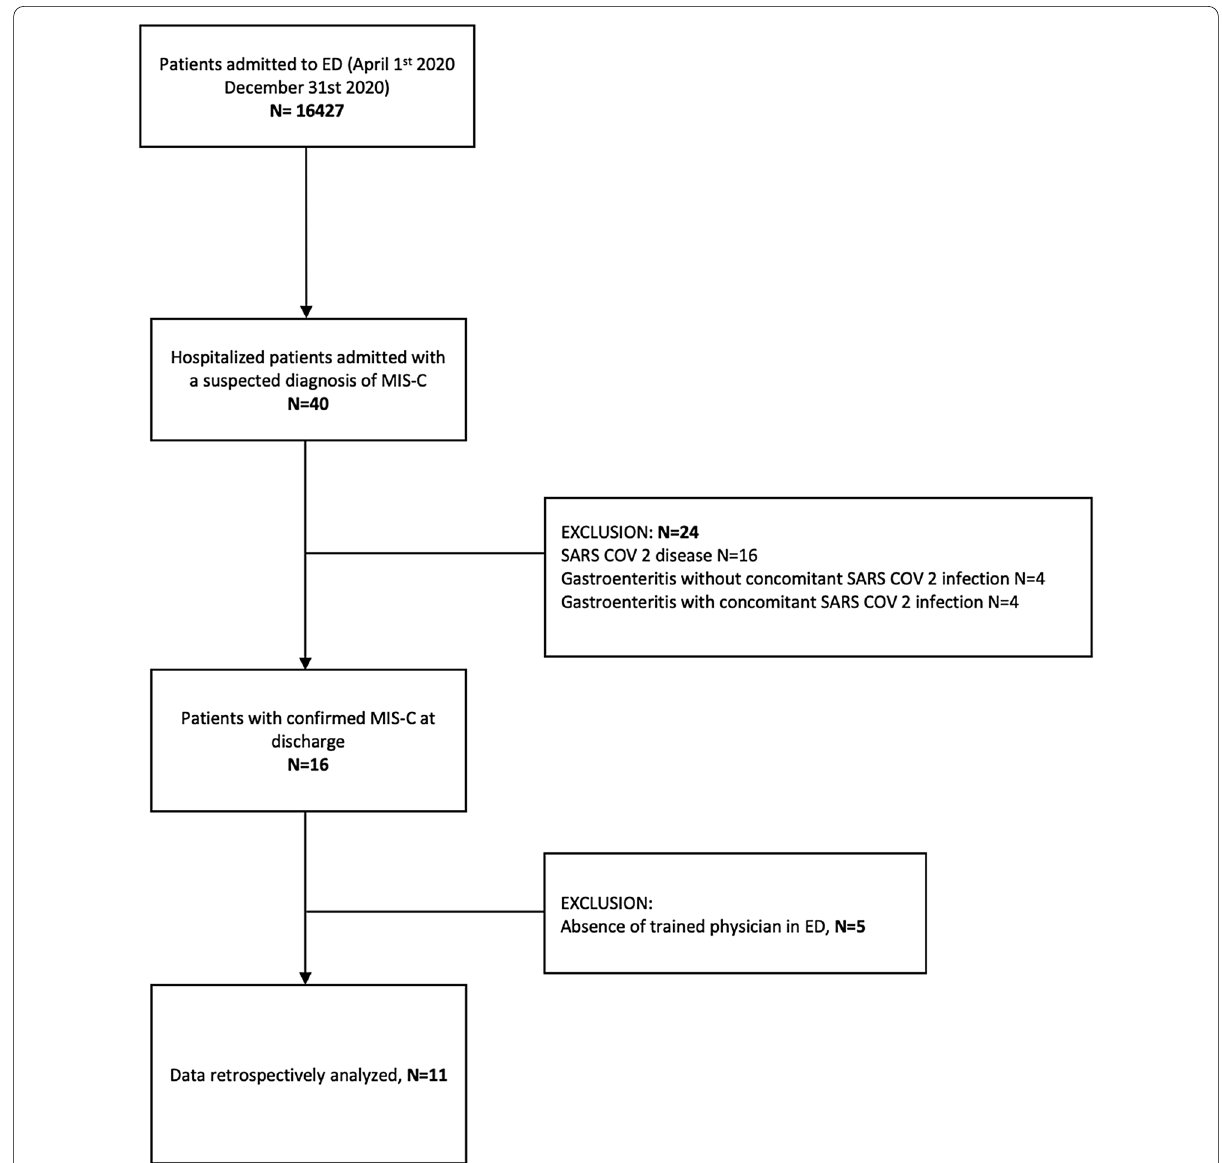
Fig. 1 Flowchart of patient enrollment and exclusion